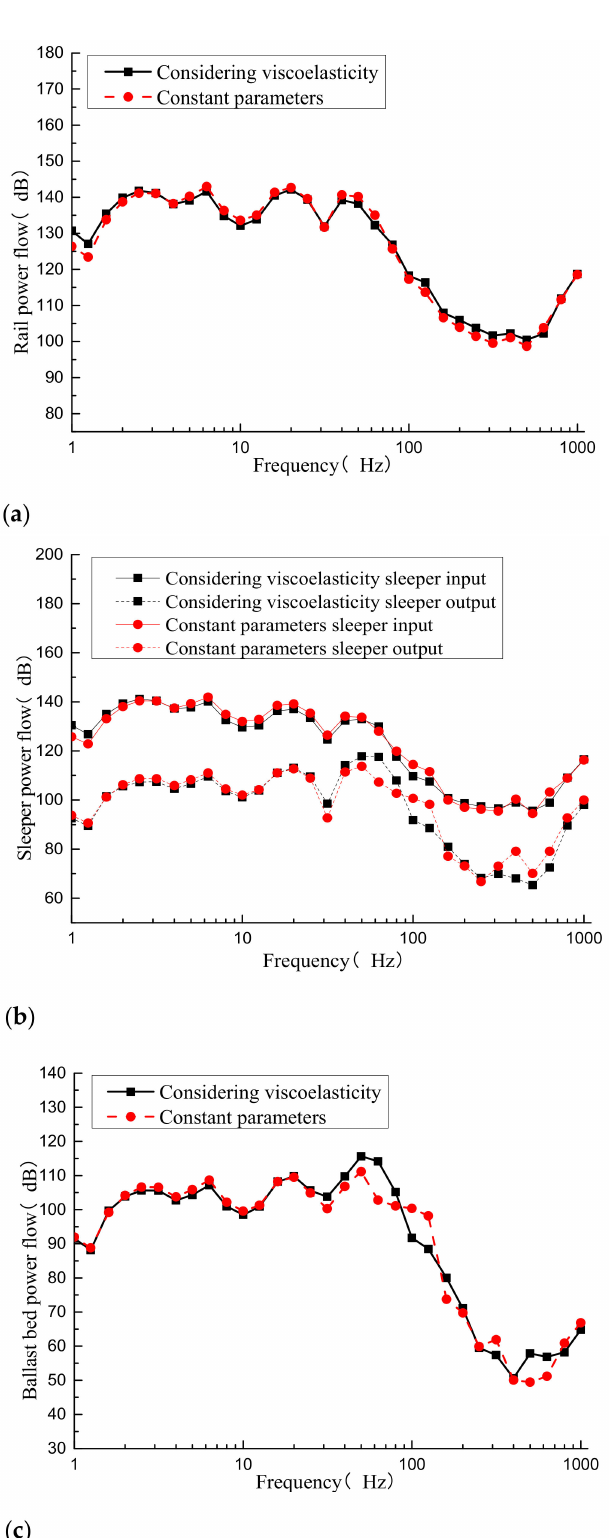
Figure 7. Power flow of track structure: ( a ) rail power flow; ( b ) sleeper input and output power flow; ( c ) ballast bed power